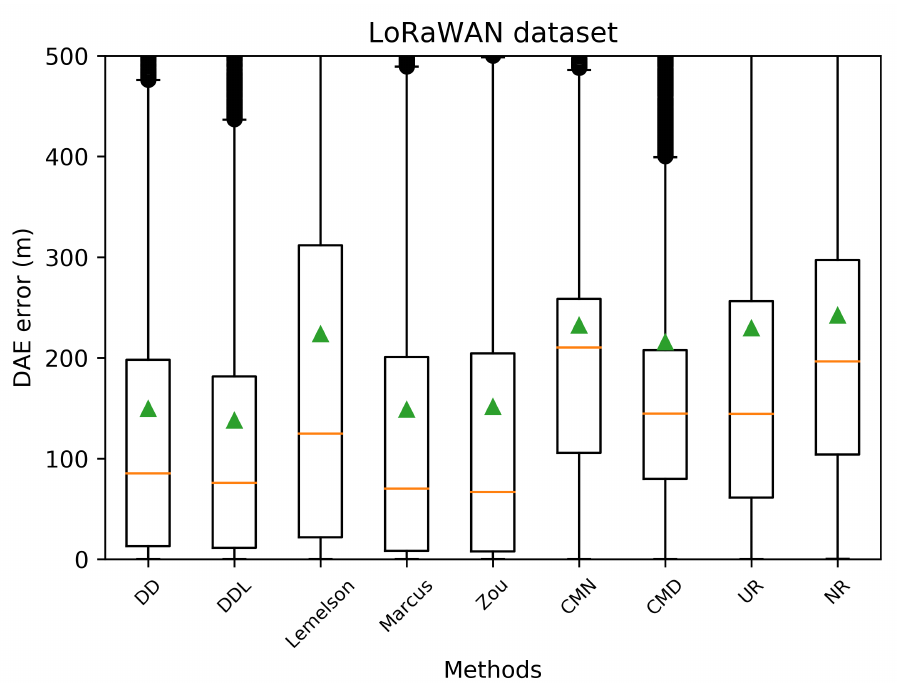
Figure 9. Boxplots indicating the distribution of the absolute DAE error of all studied methods and baselines, in the validation set of the LoRaWAN dataset. The green triangles indicate the mean values while outliers are depicted as black circles.